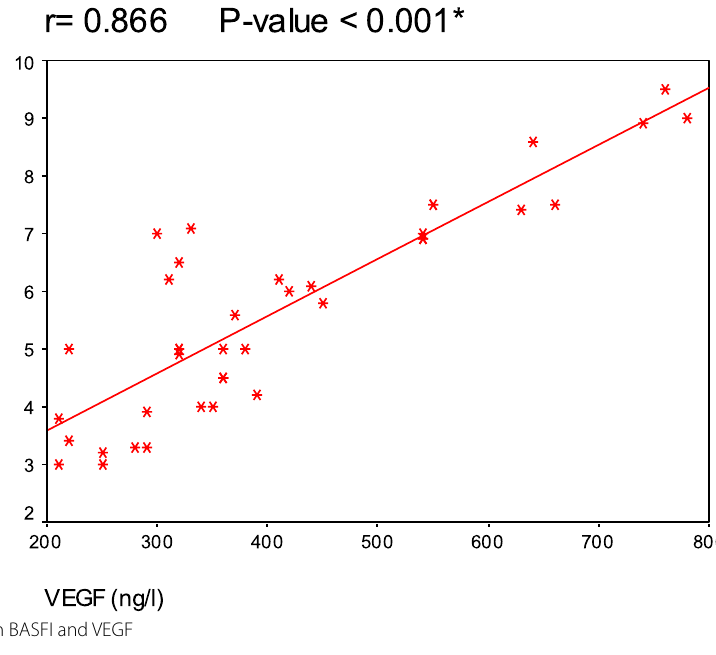
Fig. 2 Correlation between BASFI and VEGF